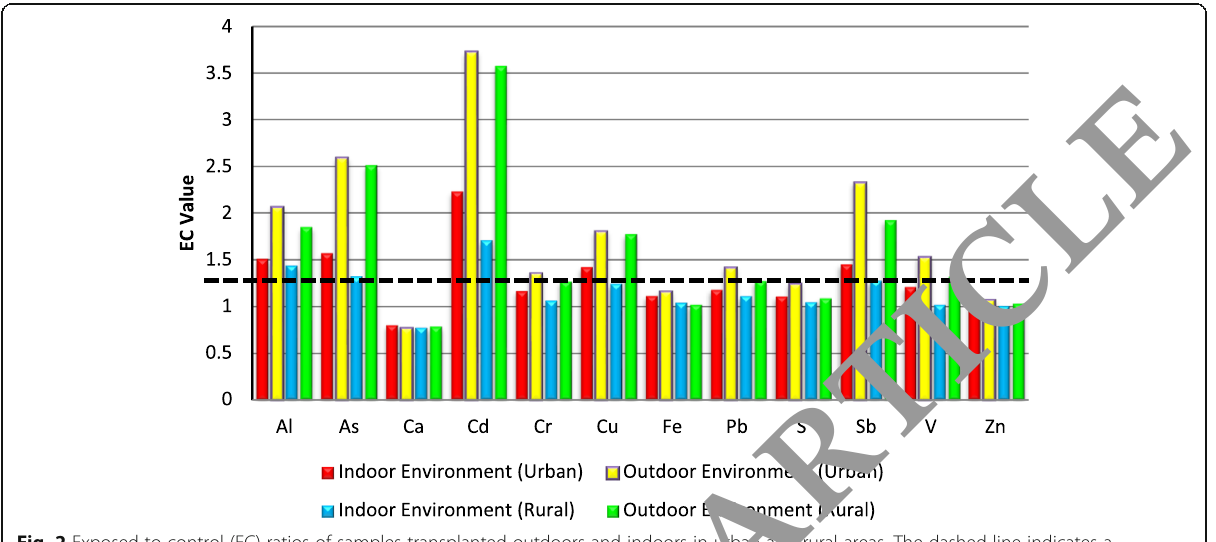
Fig. 2 Exposed to control (EC) ratios of samples transplanted outdoors and indoors in urban and rural areas. The dashed line indicates a significant accumulation (threshold EC >